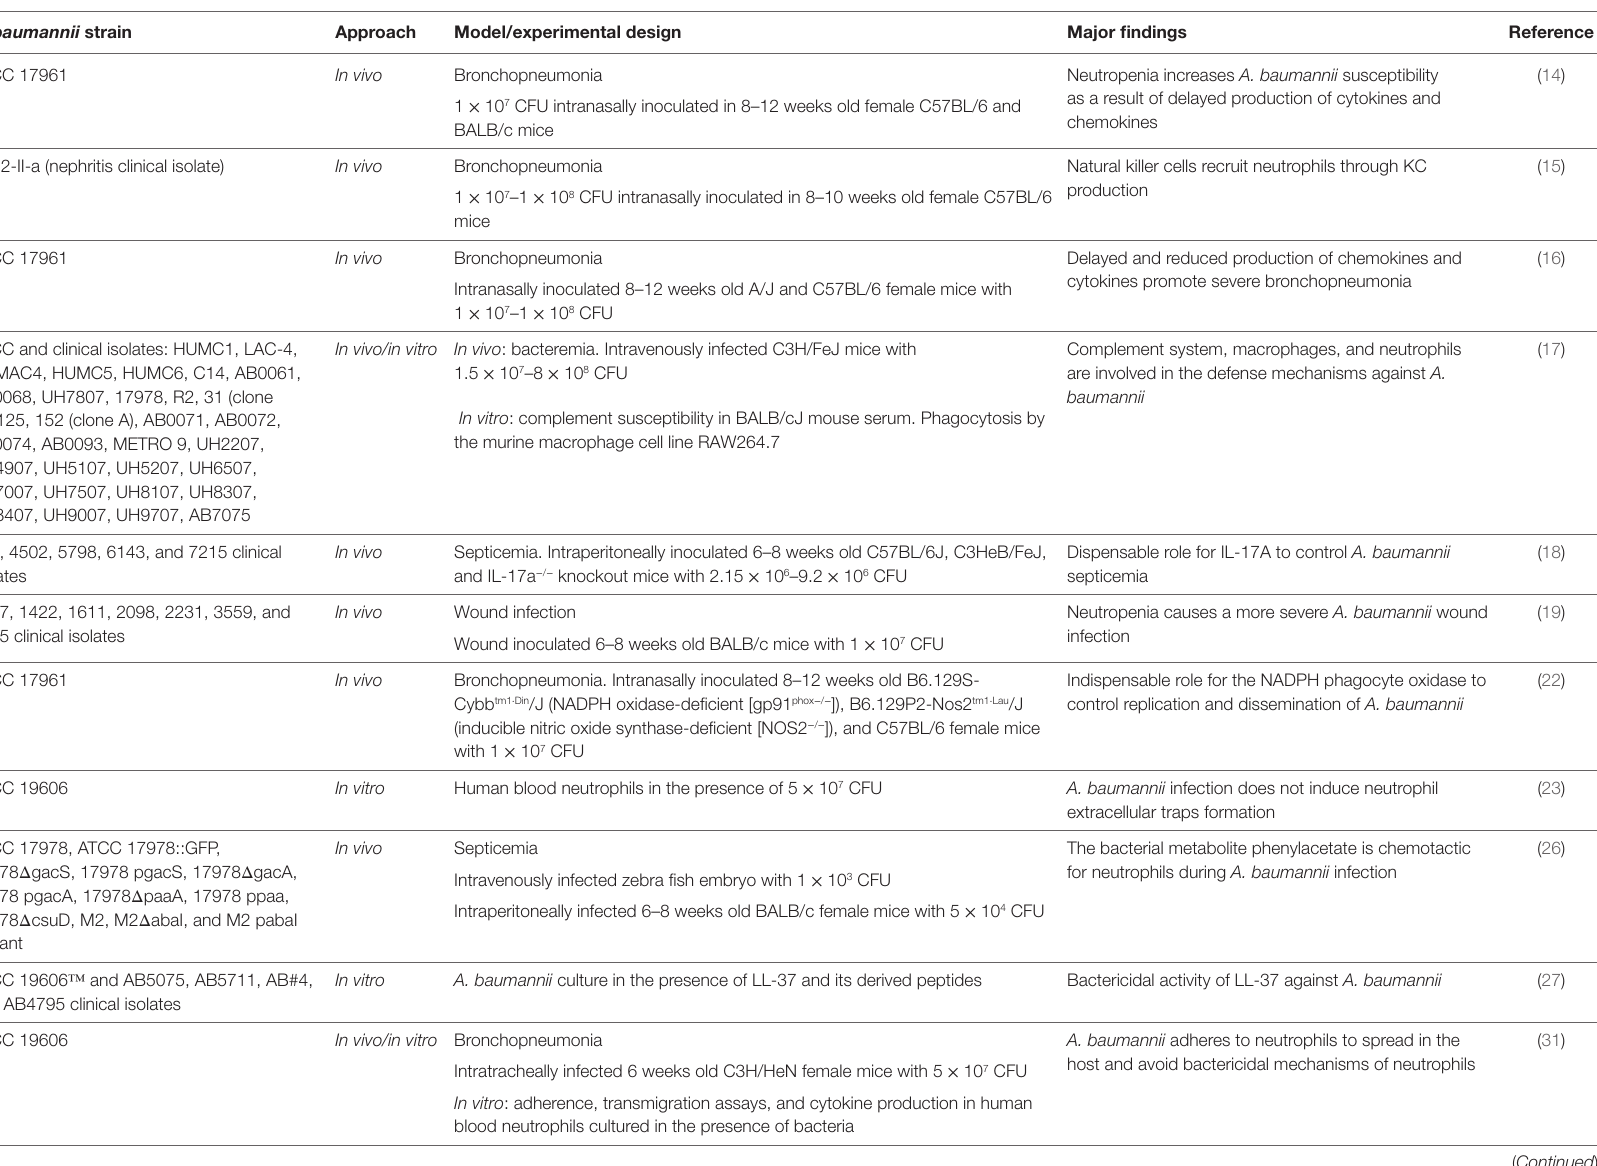
TAbLe 1 | Research models used to study host responses against Acinetobacter baumannii